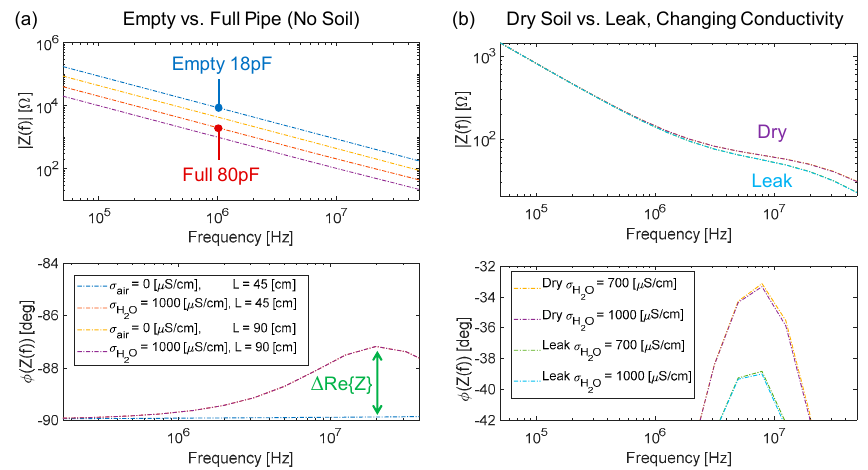
Figure 3. Bode plots (magnitude and phase) of the simulated impedance between the electrodes on the pipe in two conditions of surrounding materials: air ( a ) and soil ( b ).